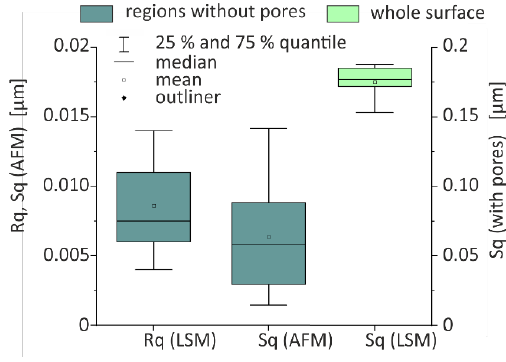
Figure A2. Surface parameter obtained from LSM and AFM.